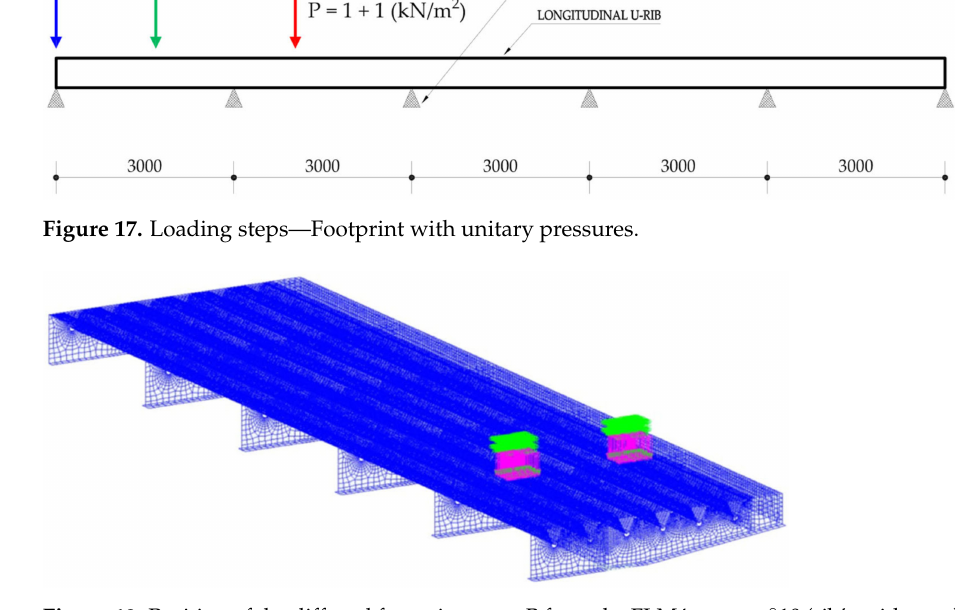
Figure 18. Position of the diffused footprints type B from the FLM4—step n ◦ 10 (rib’s mid-span)—load acting on the slow lane.